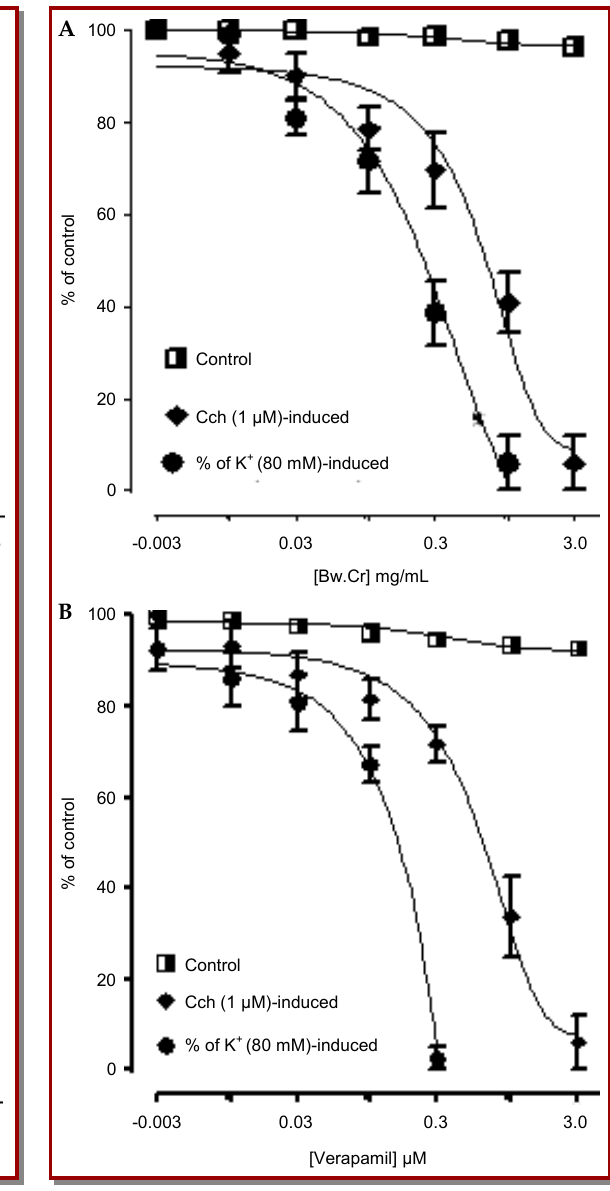
Figure 4 : Concentration-response curves of Ca +2 in the ab- sence and presence of different concentrations of (A) crude extract of B. wallichiana and (B) verapamil in isolated rabbit jejunum preparations (values are expressed as mean ± SEM, n = 3) mg/mL (1.72 – 3.21, 95% CI, n=3) respectively (Figure 6A), whereas verapamil on application to the K + (80